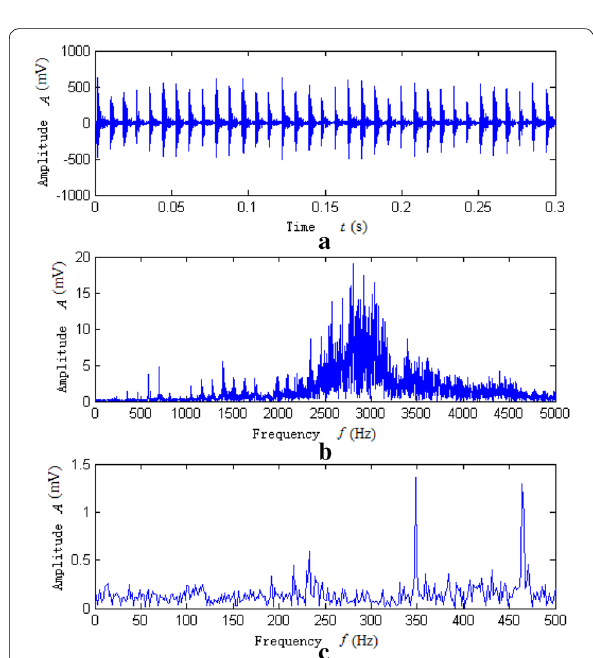
Figure 2 Outer race fault signal of N205: ( a ) time waveform, ( b ) FFT spectrum, ( c ) local spectrum